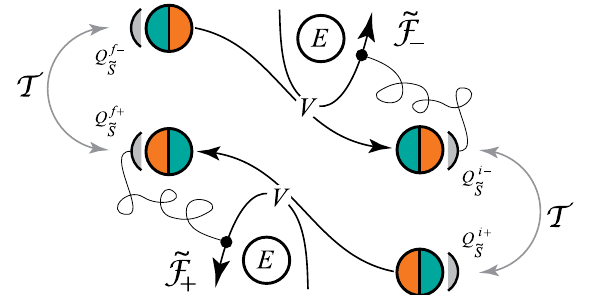
FIG. 5. Conditional fluctuation theorems. Similar to